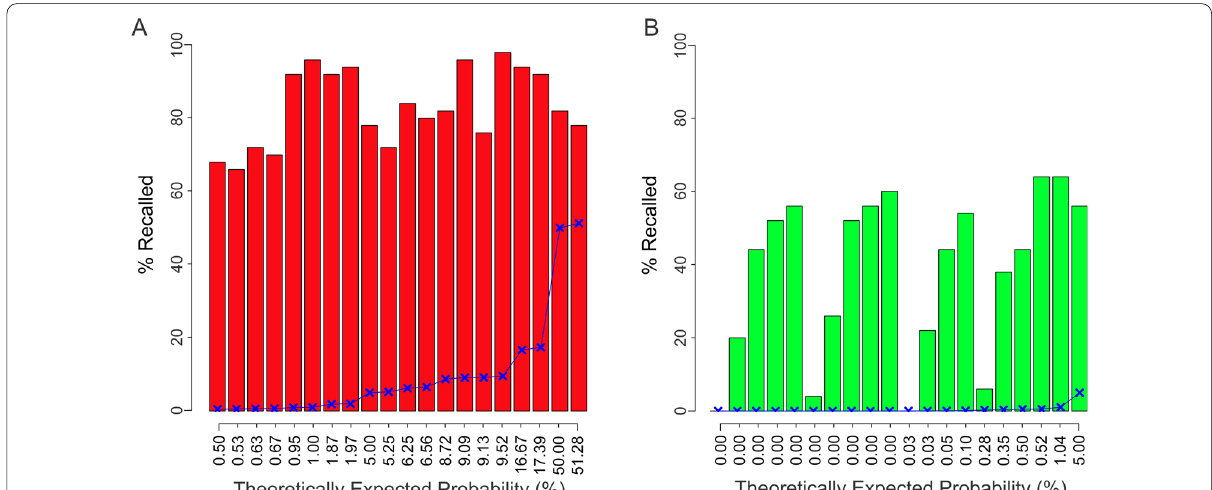
Fig. 5 Percentage of patients recalled by non-professional subjects during D-type trials in Experiment 2. A, B Conditions in which the CAD system determined the given mammogram to be positive or negative for cancer ( A, B , respectively). Note that the prominent effect of the five false alarm rate values (0.05, 0.25, 0.5, 0.75, and 0.95, in order) is especially apparent in panel B as a broadly repeating pattern of five bars starting from far left. The blue X symbols and line graphically denote the theoretically expected probabilities (also see x-axis labels). The cancer probabilities estimated by the same set of subjects during the paired E-type trials across the same conditions are shown in the same order in Fig. 3. See text for